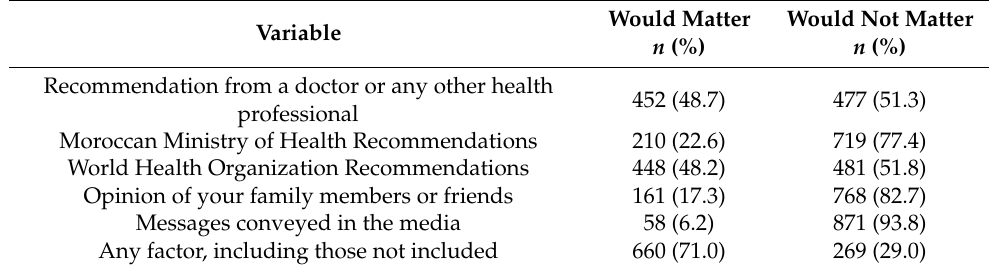
Table 4. Factors influencing non-COVID vaccination acceptance among vaccine hesitant ( n =